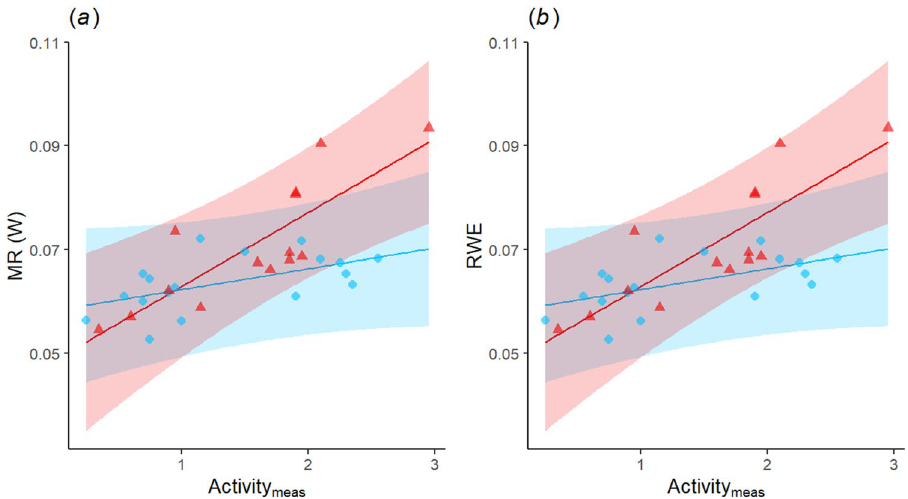
Figure 4. Partial residual plot for the effects of prenatal playbacks and activity on ( a ) metabolic rate (MR) and ( b ) relative water economy (RWE) at Max T a reached (n = 32 observations for 19 birds), for birds prenatally exposed to either heat-calls (red triangles) or contact calls (blue dots). Regression lines and confidence intervals (for significant effects) were plotted using the function interact_plot from interactions R package.